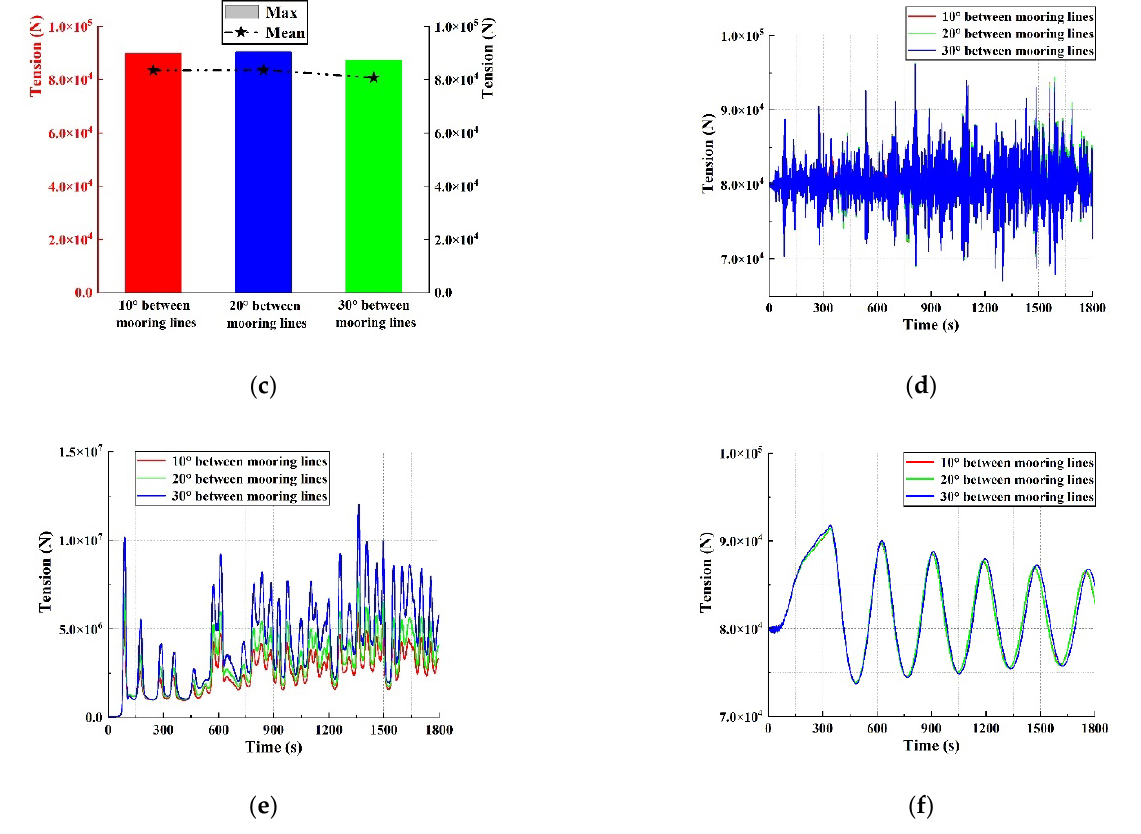
Figure 22. Influence of the angle between mooring lines on mooring line tension. ( a ) Maximum and mean values of mooring system tension under wave loads; ( b ) maximum and mean values of mooring system tension under level ice loads; ( c ) maximum and mean values of mooring system tension under broken ice floes loads; ( d ) the tension of mooring line 1 under wave load in time-domain analysis; ( e ) the tension of mooring line 1 under level ice load in time-domain analysis; ( f ) the tension of mooring line 1 under broken ice floes load in time-domain analysis.